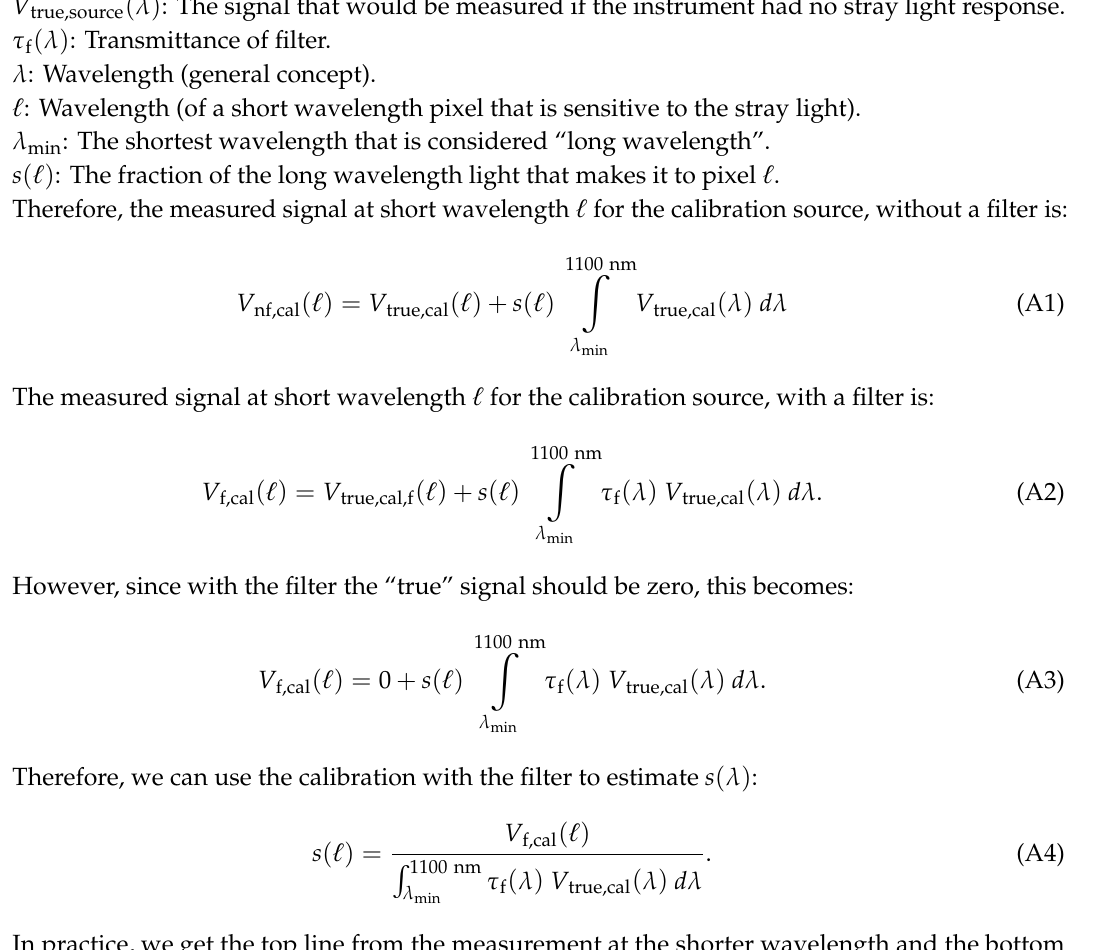
Figure A3. Source measured radiance with and without a 550 nm cut on a filter (left vertical axis) and the transmittance of that filter (right vertical axis, logarithmic scale).